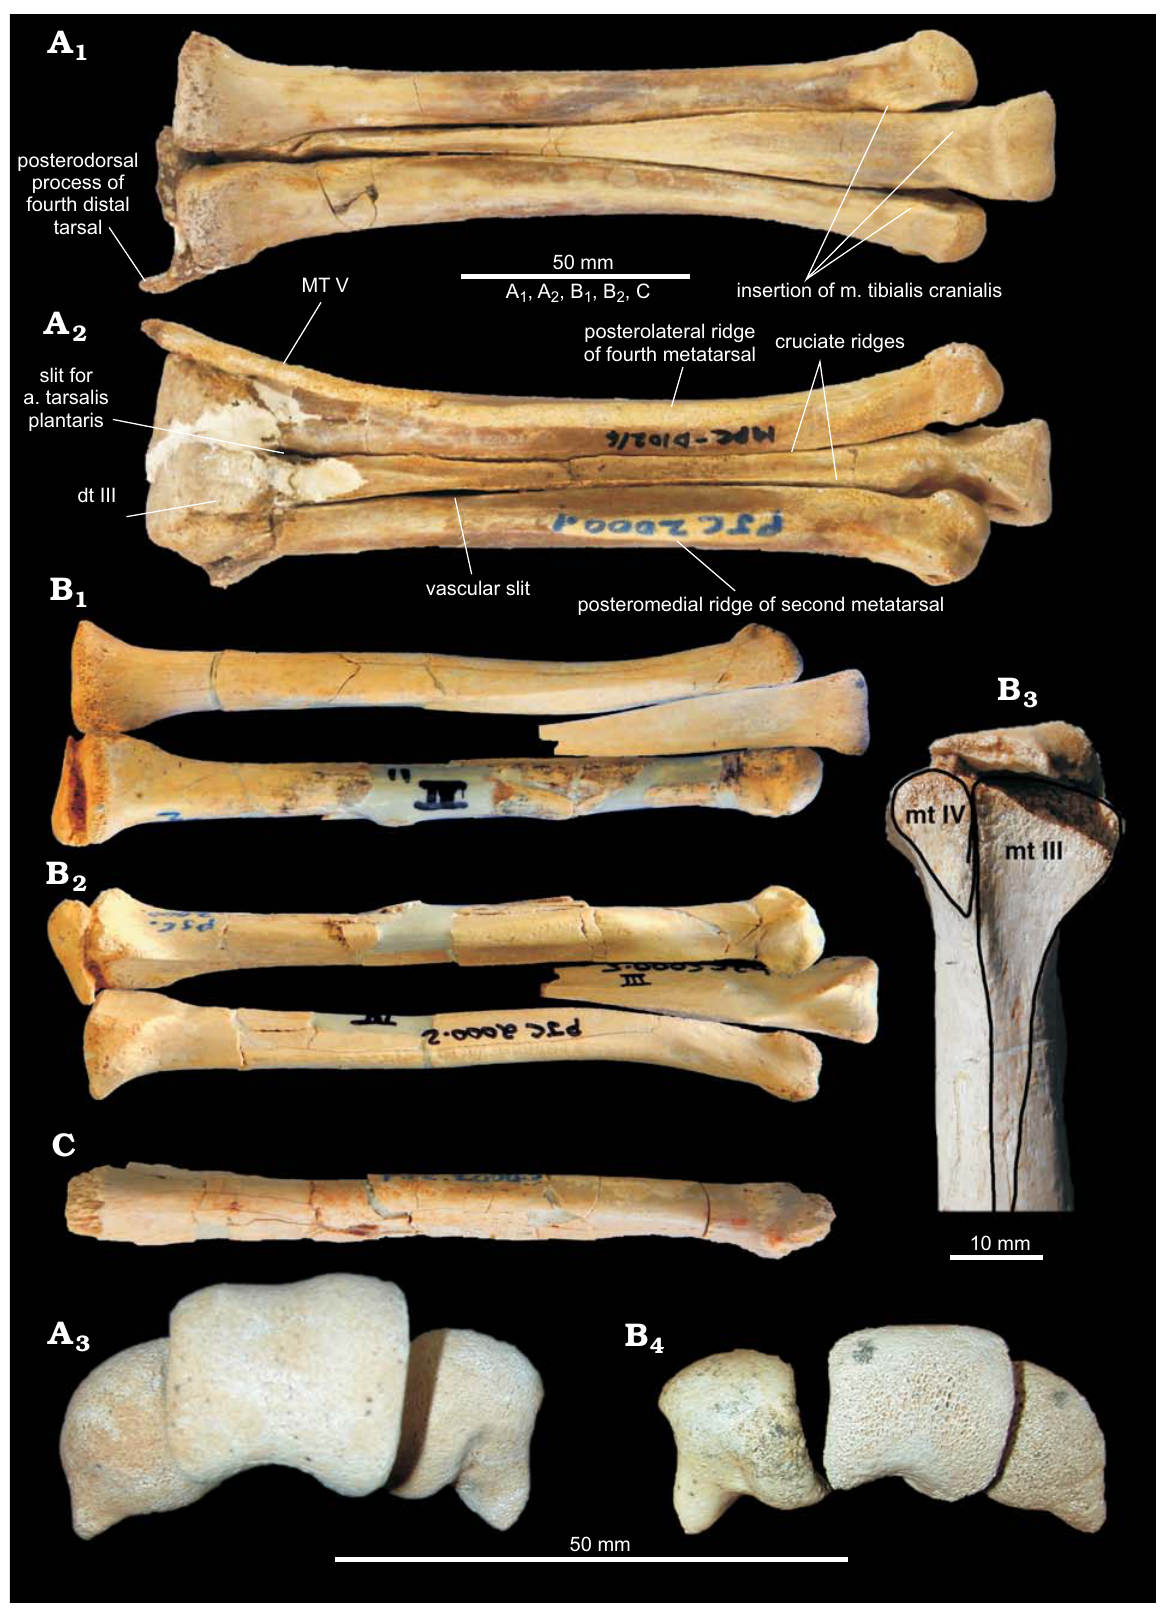
Fig. 9 Crested theropod dinosaur Elmisaurus rarus Osmólska, 1981, MPC-D 102/006 ( A ), MPC-D 102/007 ( B ), MPC-D 102/008 ( C ) from Nemegt Formation (Upper Cretaceous), Western Sayr of Nemegt locality, Mongolia. Tarsometatarsals in anterior (A 1 , B 1 ), posterior (A 2 , B 2 ), lateral (C), and distal (A 3 , B 4 ) views. In B 1 and B 2 , the left metatarsal III has been mirrored and associated with the right metatarsi II and